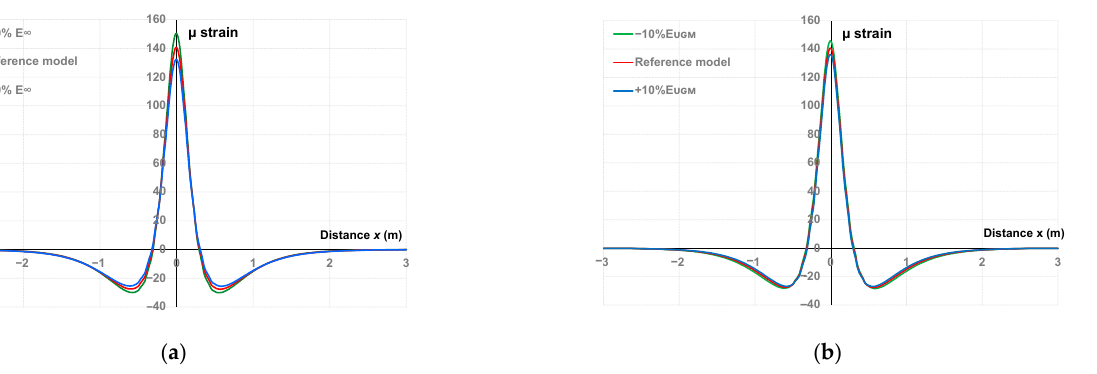
Figure 8. Fitting of the proposed numerical model to the reference signal with ( a ) ± 10% variation for E ∞ , ( b ) ± 10% variation for E UGM .